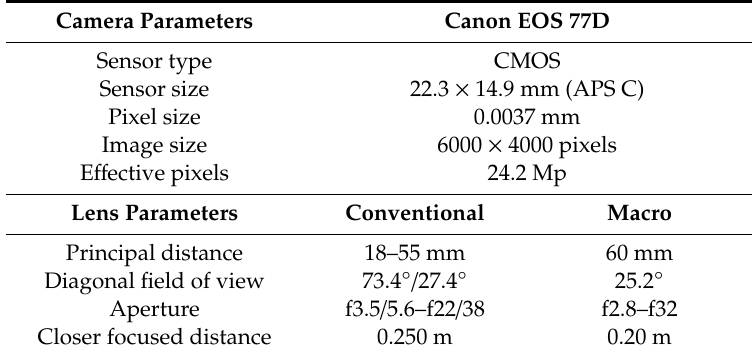
Table 2. Technical specifications of the photogrammetric system. CMOS: Complementary Meta Oxide Semiconductor.